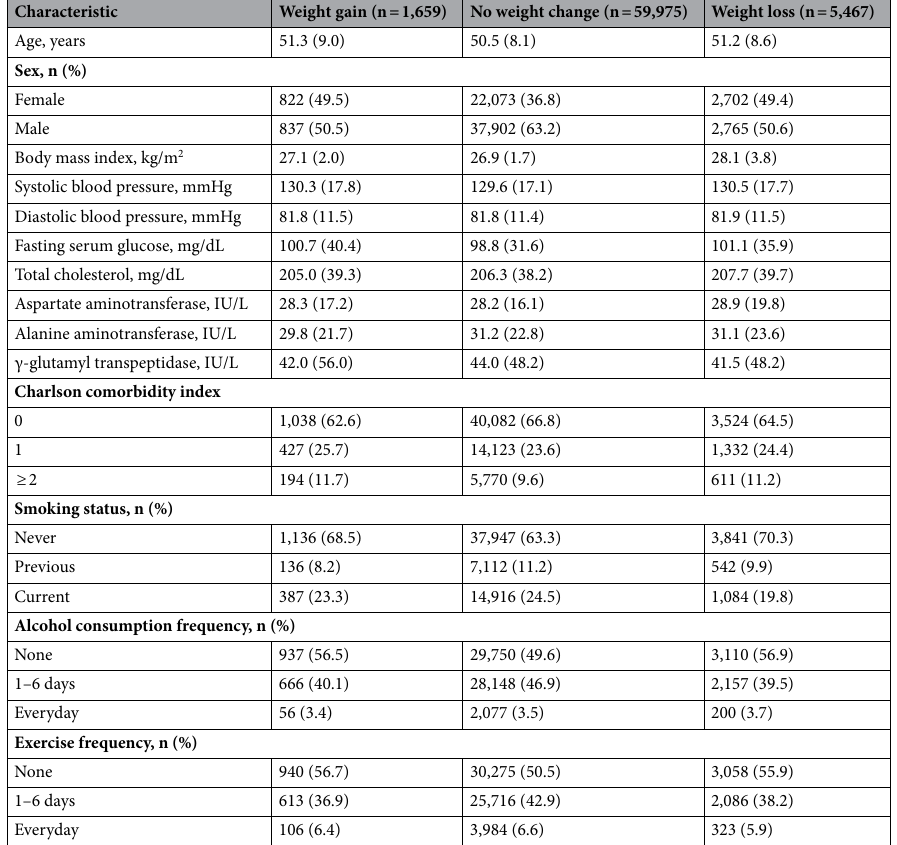
Table 1. Demographic characteristics of the obese adults according to the body mass index at second period (2004–2005). Data are mean (standard deviation) unless indicated